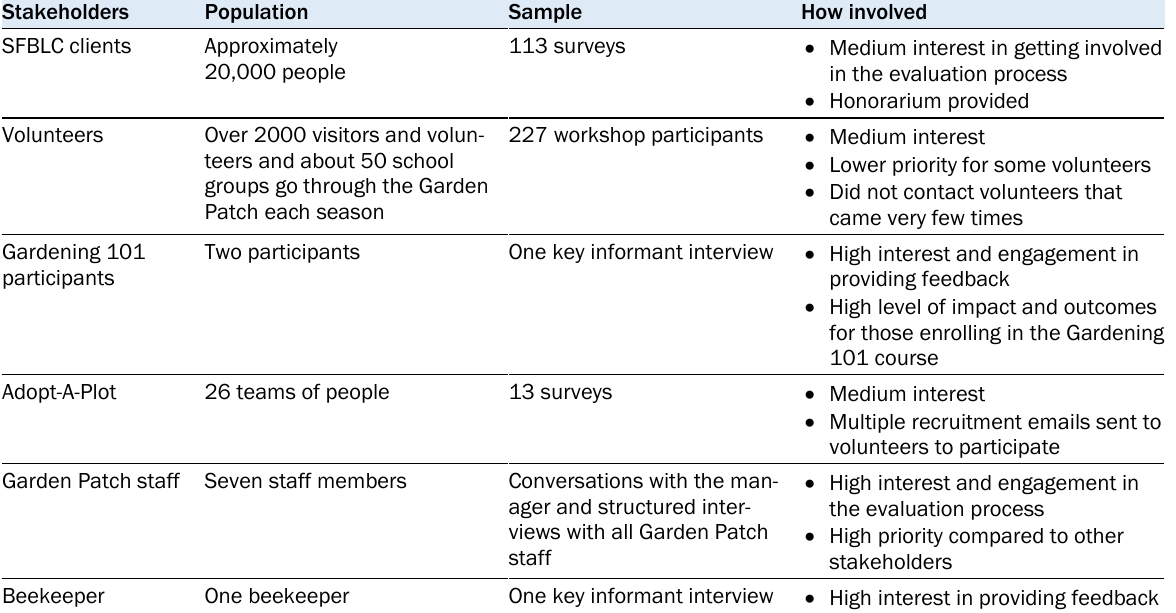
Table 1. Stakeholder Involvement